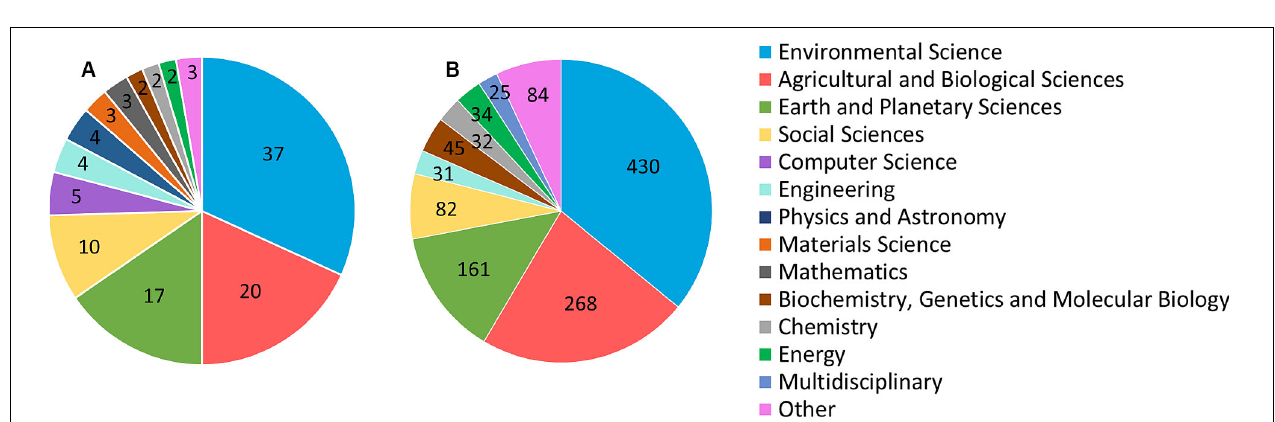
FIGURE 4 | (A) Overview of research foci in the SMART EMJD, within the three major river science components: Water flow, Biota and Landforms. (B) Percentage contribution of each research focus across all the 36 doctoral theses.